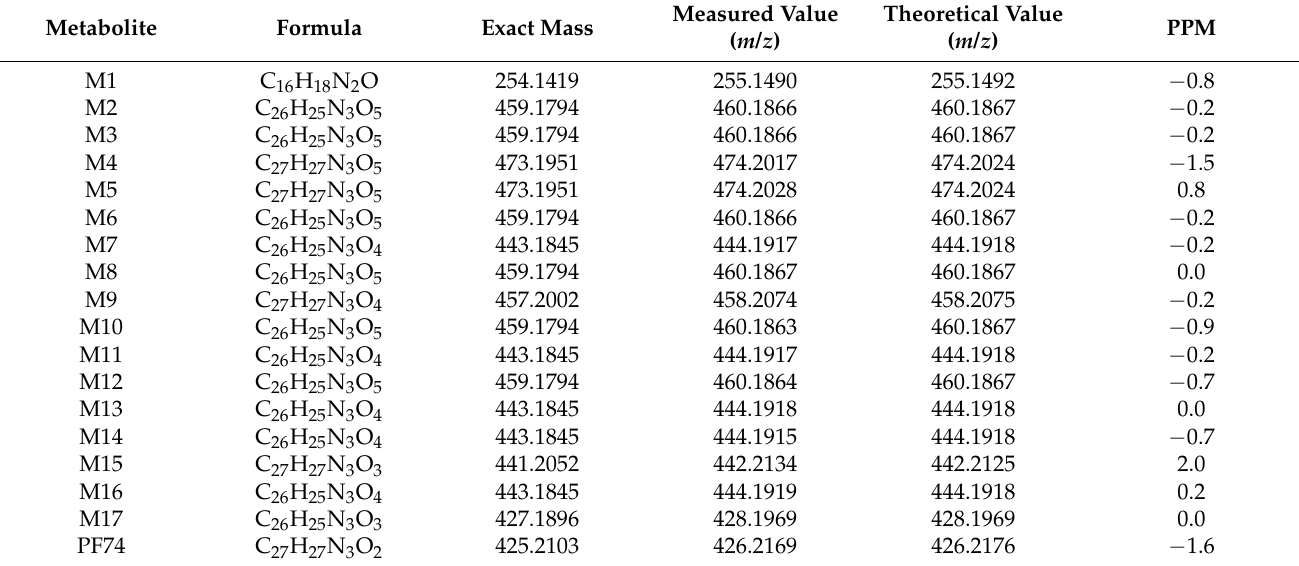
Table 2. Accurate quality detection information of PF74 and its metabolites in